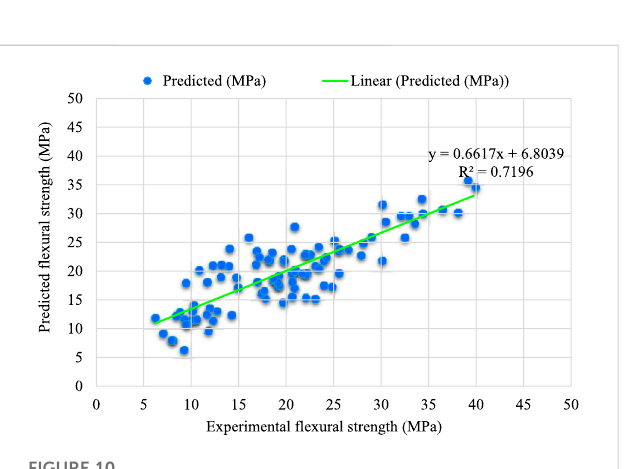
FIGURE 10 Experimental and predicted results for UHPC FS — MLP model.